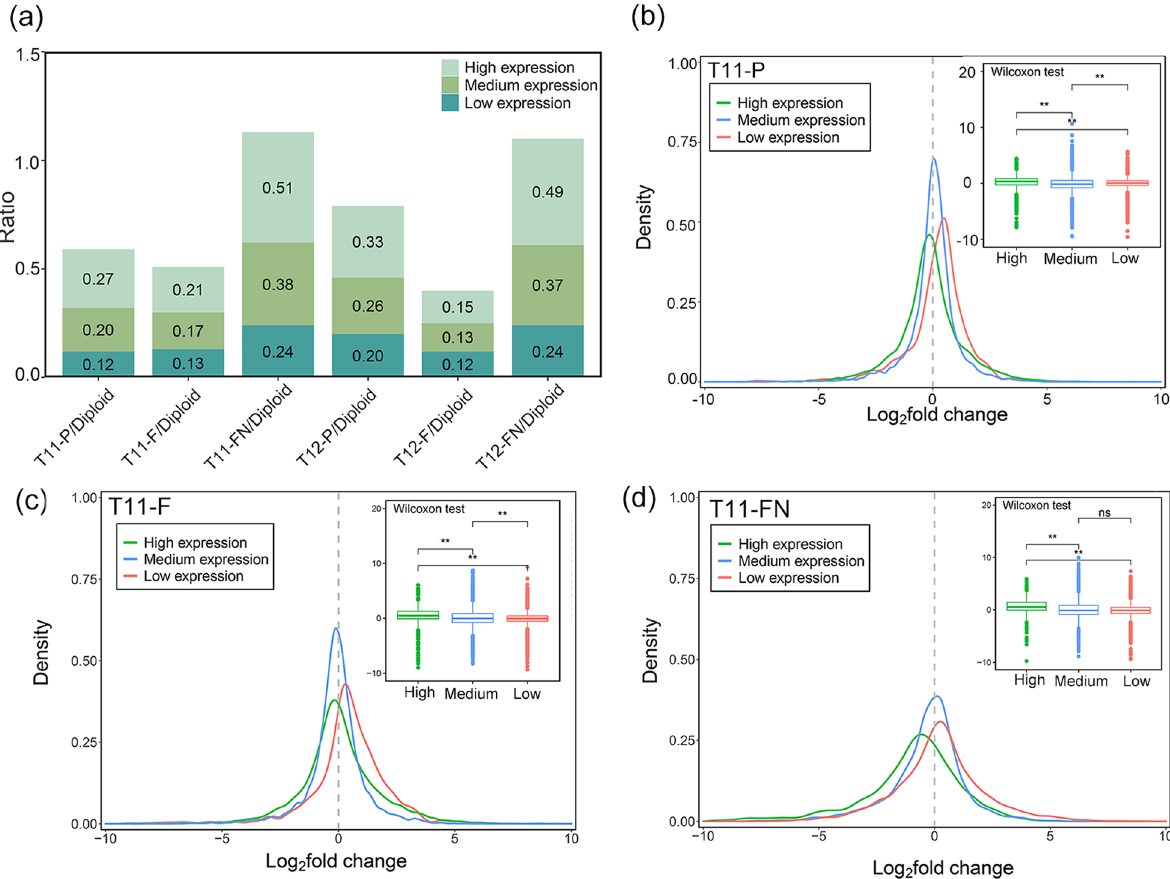
Fig. 3 Impact of extra chromosomes on changes in gene expression. a Proportions of DEGs with different expression levels in T11 (T11-P, T11-F and T11-FN) and T12 (T12-P, T12-F, T12-FN). Based on the expression levels of Zhongxian 3037, genes were divided into three clusters: (i) high-expression genes (FPKM > 100), (ii) medium-expression genes (10 < FPKM 100) and (iii) low-expression genes (0 < FPKM 10). Y-axis represents the proportion ≤ ≤ of DEGs in different expression level genes. b , c and d The Log 2 (fold change) frequency distribution of genes with different expression levels in T11-P, T11-F and T11-FN, respectively. X-axis represents the Log 2 (fold change) in gene expression levels between diploid and trisomy and Y-axis represents frequency distributions of Log 2 (fold change). The red, blue and green lines indicate low (0 < FPKM 10), medium (10 < FPKM 100) ≤ ≤ and high (FPKM > 100) -expression genes, respectively; ns, not significant Boxplot on the right is a statistical analysis of the expression levels of the different types of genes (Wilcoxon test, ** p- value <